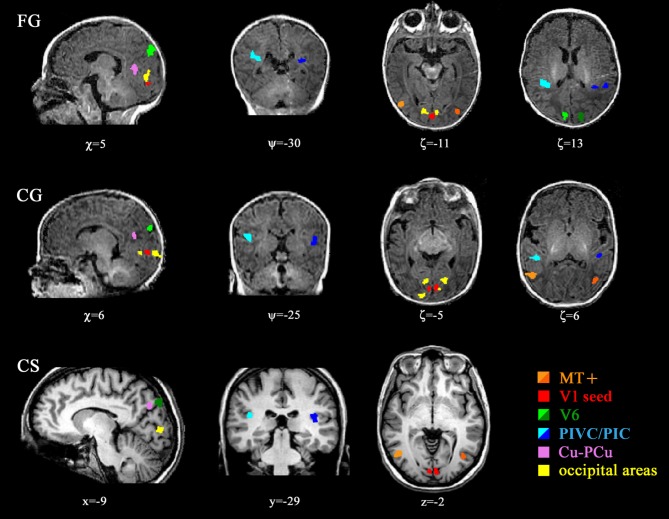
Localization of the motion-network areas.Example of localization and extension of all major areas (ROIs) in two infants (FG and CG) and one adult (CS, bottom row). Light colours for right hemispheres, dark colours for left hemispheres. The location of each bi-dimensional section is indicated in millimetres from AC point for infants (“χ, ψ, ζ” notation) and in Talairach coordinates for adults (“x, y, z” notation). Note that the V1 seed was bilateral and has been labelled on the response to motion versus blank (V1 seed). Several occipital areas labelled in yellow are not included in the detailed analysis, given the difficulties in distinguishing between them in infants. (V1: primary visual cortex; MT+: temporo-occipital complex; V6: Visual area six on medial-parieto-occipital region; PIVC/PIC: posterior insular vestibular cortex and posterior insular cortex respectively; PCu/Cu: Pre-Cuneus/Cuneus.) Numerical data of size and localization are reported in Table 1.